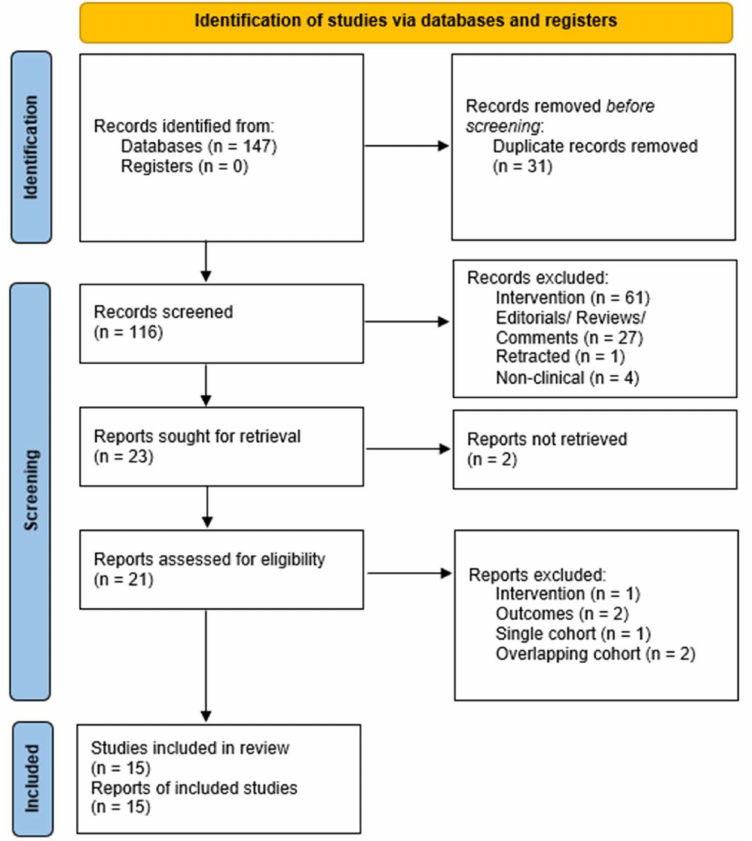
Figure 1. Study selection